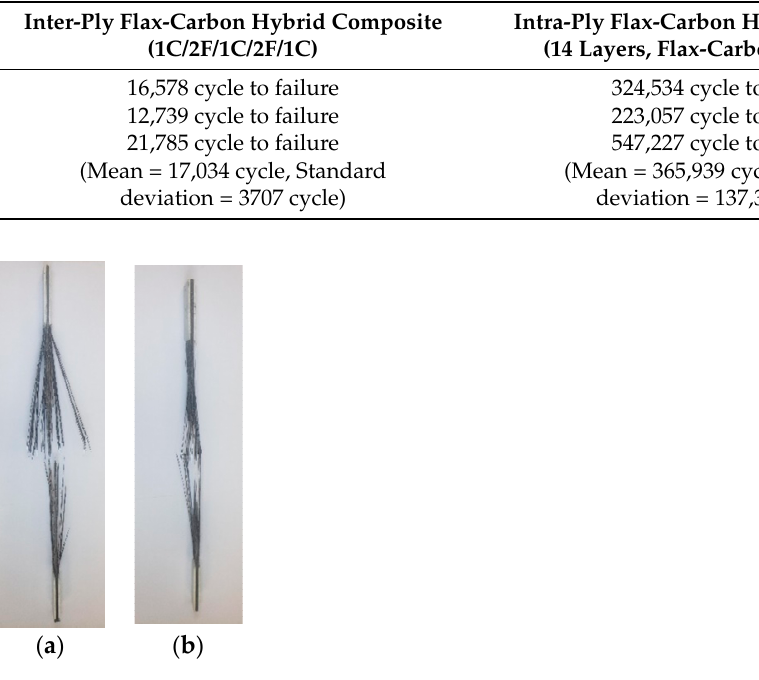
Figure 5. Failed specimens during fatigue testing of ( a ) inter-ply (1C/2F/1C/2F/1C), ( b ) intra-ply (14- layer, co-woven) hybrid composites. (14-layer, co-woven) hybrid Table 3. Fatigue test results for inter-ply and intra-ply flax-carbon hybrid composites (three sample for each type).